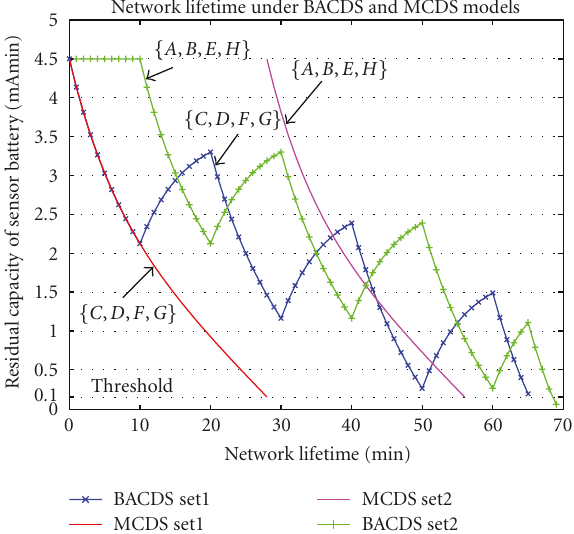
Figure 4: The sensor network in Figure 1 achieves longer lifetime using the BACDS model than the MCDS model. The results were simulated with the battery discharging model. In this case, the net- work lifetime is prolonged by 23 . 2% in the BACDS model.